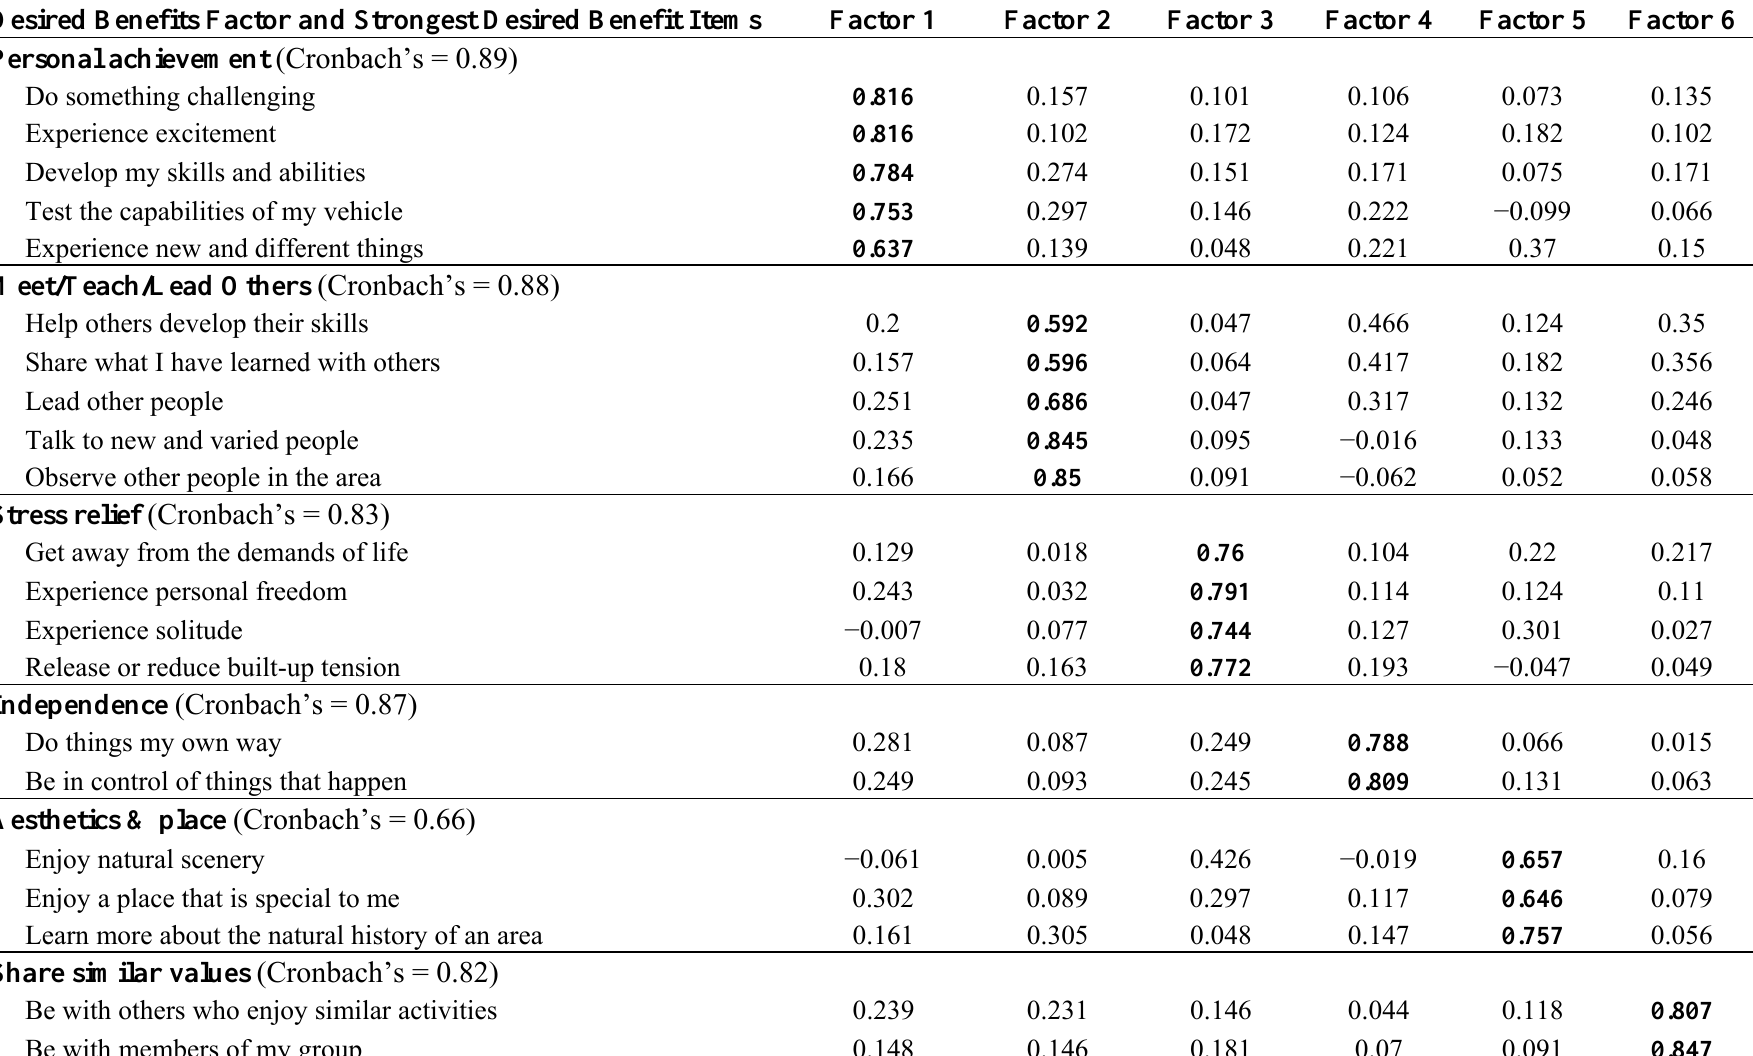
Table 3. Factor loadings of recreation experience